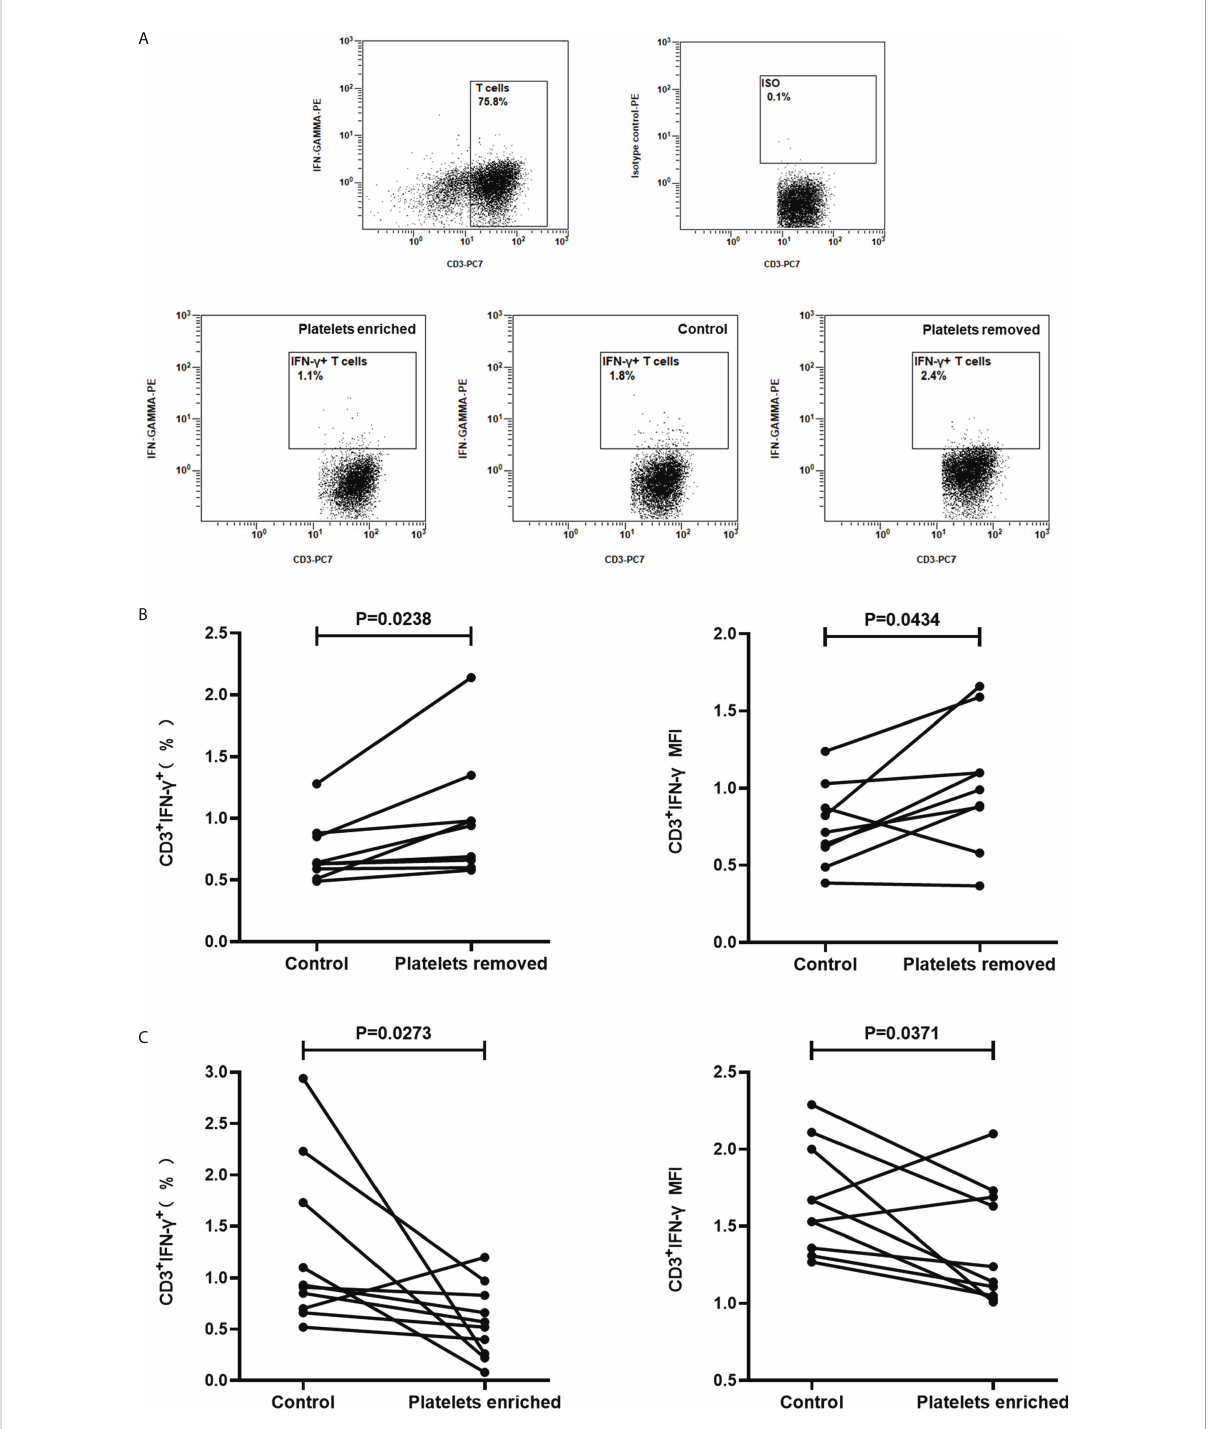
FIGURE 7 Regulating the frequencies of platelets in PBMCs signi fi cantly affects the production of IFN- g in T cells. Platelets-removed PBMCs (n=9) or platelets-enriched PBMCs (n=9) were stimulated with PHA and the production of IFN- g in T cells was measured by FCM. (A) Representative fl ow cytometry scatter plots of IFN- g production in T cells. (B, C) The frequencies of IFN- g -producing T cells and the mean fl uorescence intensity (MFI) upon platelet removal or platelet enrichment were compared with the control group by paired Student ’ s